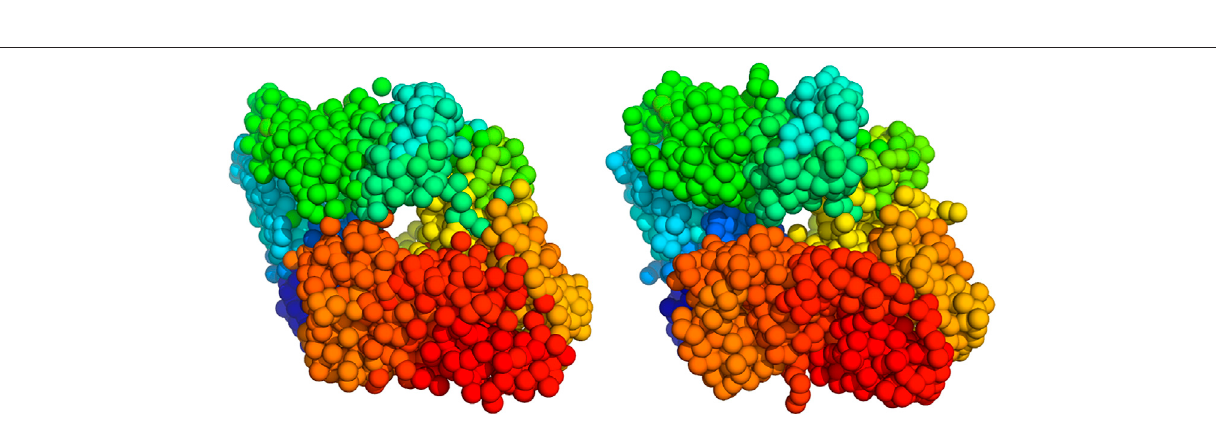
FIGURE 9 | 3D models of beta-galactosidase (Left) 2000 particle model inferred with Bayesian random tomography (Right) Coarse-grained model of the atomic structure (PDB code